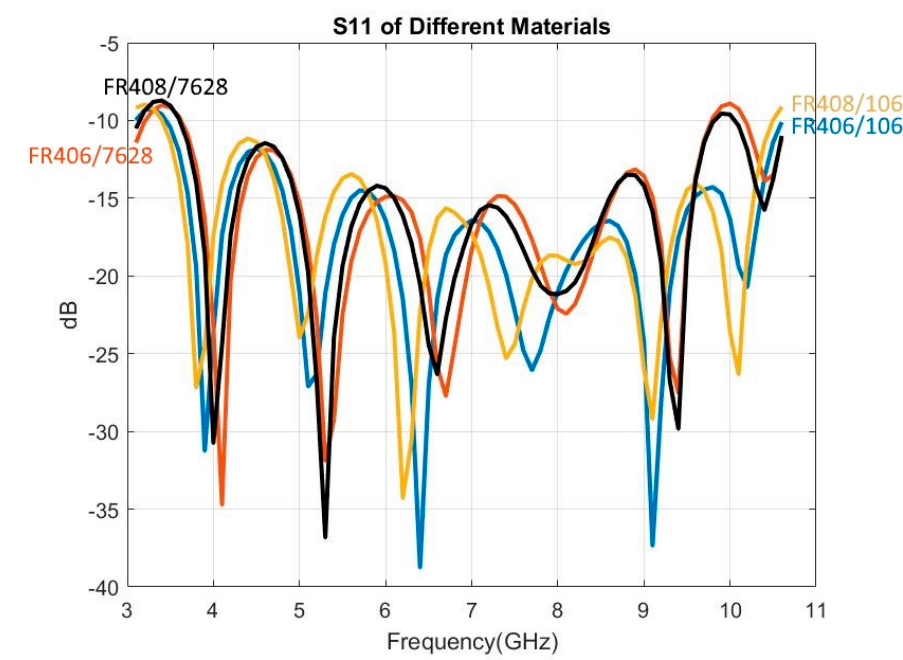
Figure 10. Materials impact on S11 (blue: FR406 type 106, red: FR406 type 7628, yellow: FR408 type 106, black: FR408 type 7628).